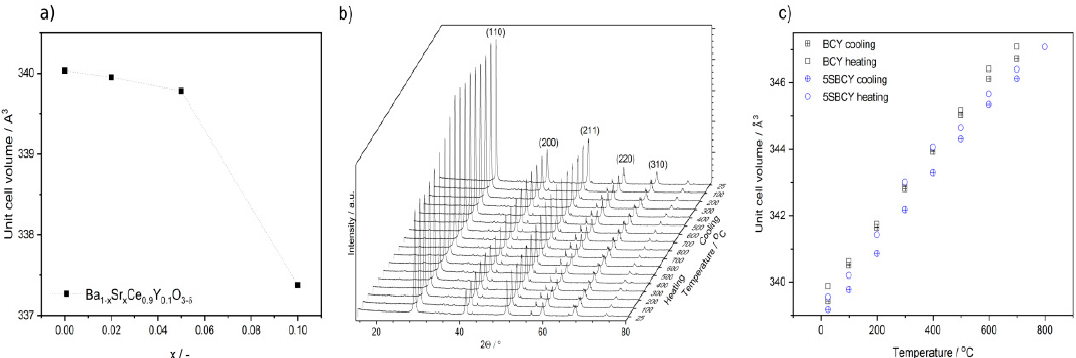
Figure 2. Variation in the cell volume of Ba 1 − x Sr x Ce 0.9 Y 0.1 O 3 − δ vs chemical composition at RT ( a ); XRD patterns collected for Ba 0.95 Sr 0.05 Ce 0.9 Y 0.1 O 3 − δ (5SBCY) during the heating-cooling cycle within the temperature range 25–800 °C ( b ) variation in BaCe 0.9 Y 0.1 O 3 − δ (BCY) and 5SBCY cell volume vs